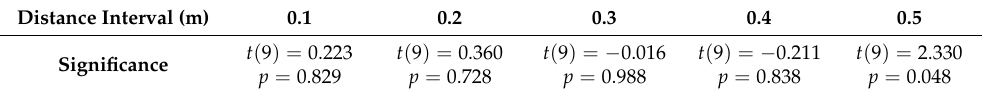
Table 1. Significant differences in task completion time at different depth distance